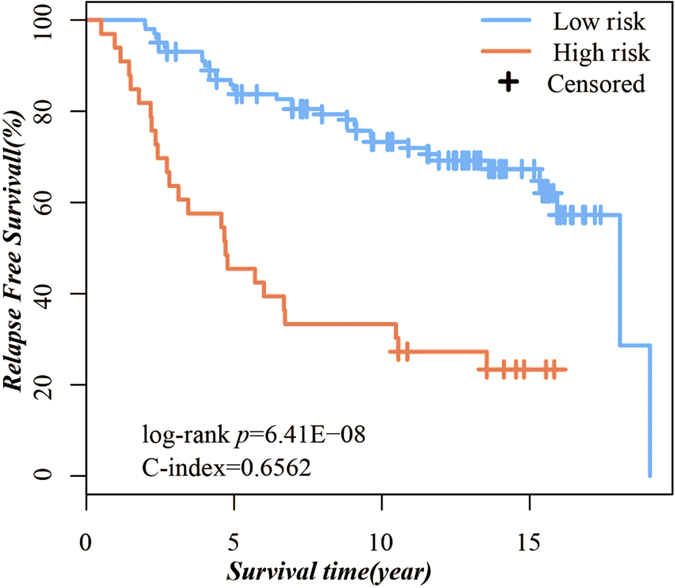
Kaplan–Meier curves illustrating relapse-free survival among patients with ER+ breast cancer based on Prognostic gene pairs in the training set.